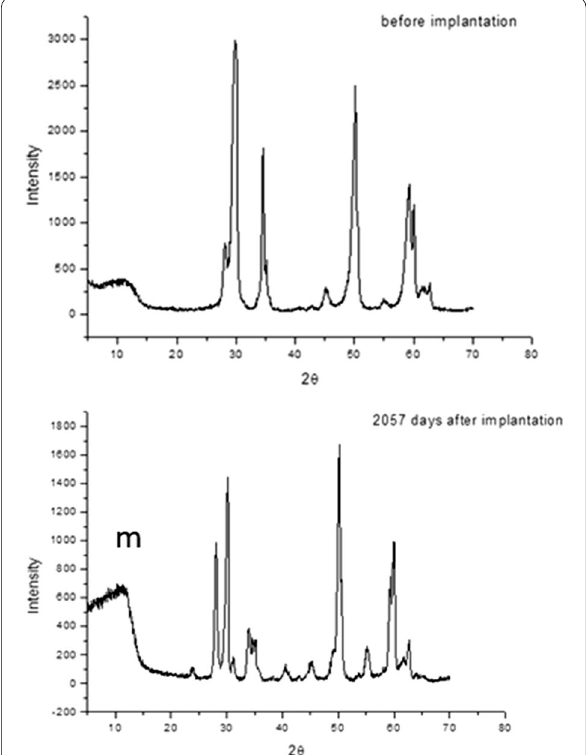
Fig. 5 X‑ray patterns of the zirconia femoral ball. Original and femoral ball retrieved after 2057 days in vivo, where the peak with m is characteristic of monoclinic phase